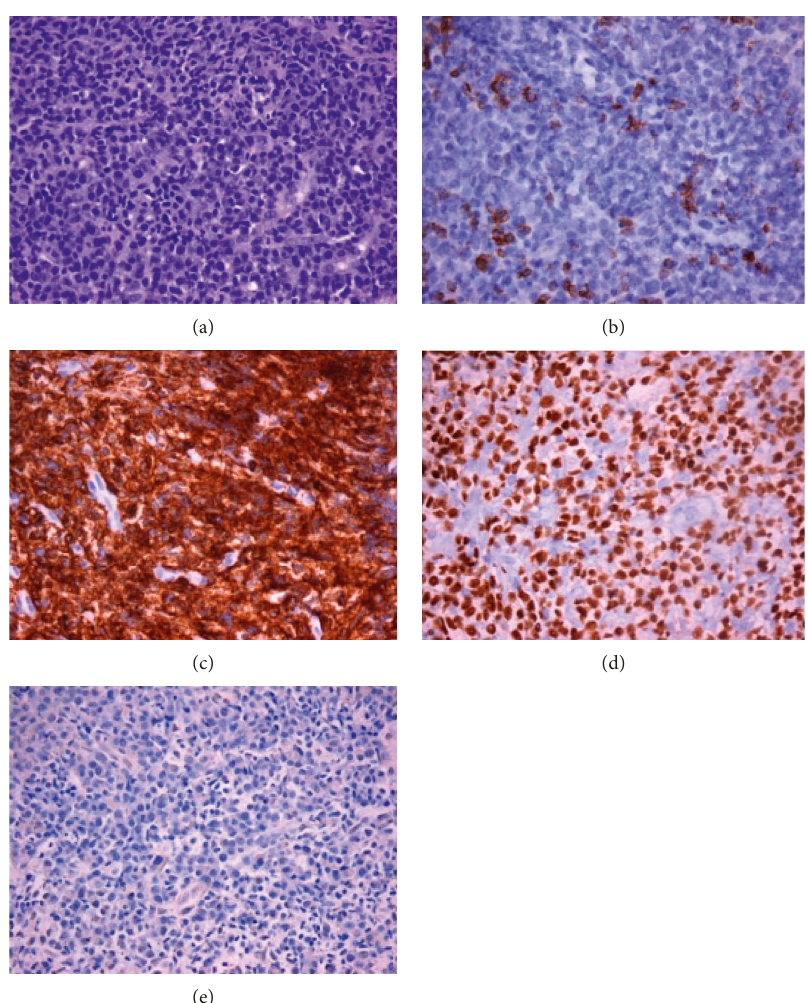
Figure 1: (a) Large atypical lymphoid tumor cells with plasmacytoid morphology, abundant cytoplasm, and eccentric large nuclei with vesicular chromatin, some of which demonstrate nucleoli (H&E 40x). (b) Tumor cells were negative for CD20 antigen. Some positive reactive B lymphocytes can be discerned. Intense, uniform immunoreactivity for plasmacytoid differentiation-associated antigens CD138 (c) and MUM-1 (d). (e) EBER in situ hybridization was